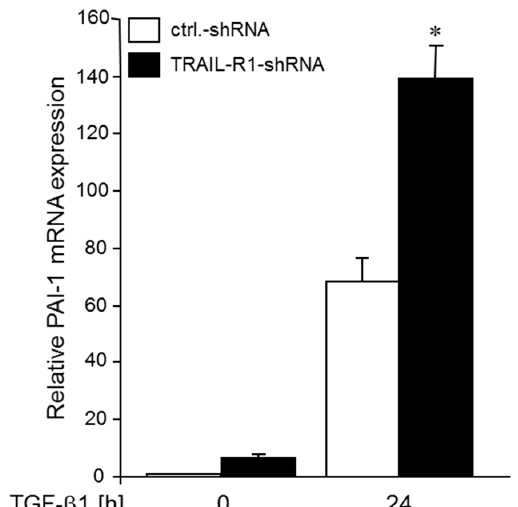
Figure 7. Knockdown of TRAIL-R1 in Colo357 cells enhances TGF β 1-mediated induction of PAI-1 expression. Colo357 cells stably transduced with a TRAIL-R1 shRNA, or control (ctrl.) shRNA remained unstimulated (0) or were stimulated with TGF β 1 (5 ng/mL) for 24 h. Cells were assayed for PAI-1 mRNA expression by qPCR. Data represent the mean ± SD of three independent experiments ( n = 3). The asterisk (*) indicates significance relative to control ( p < 0.05). 2.8. Ectopic Expression of a miR-370-3p Mimic Partially Reverses the TRAIL-R1 shRNA-induced TGF β